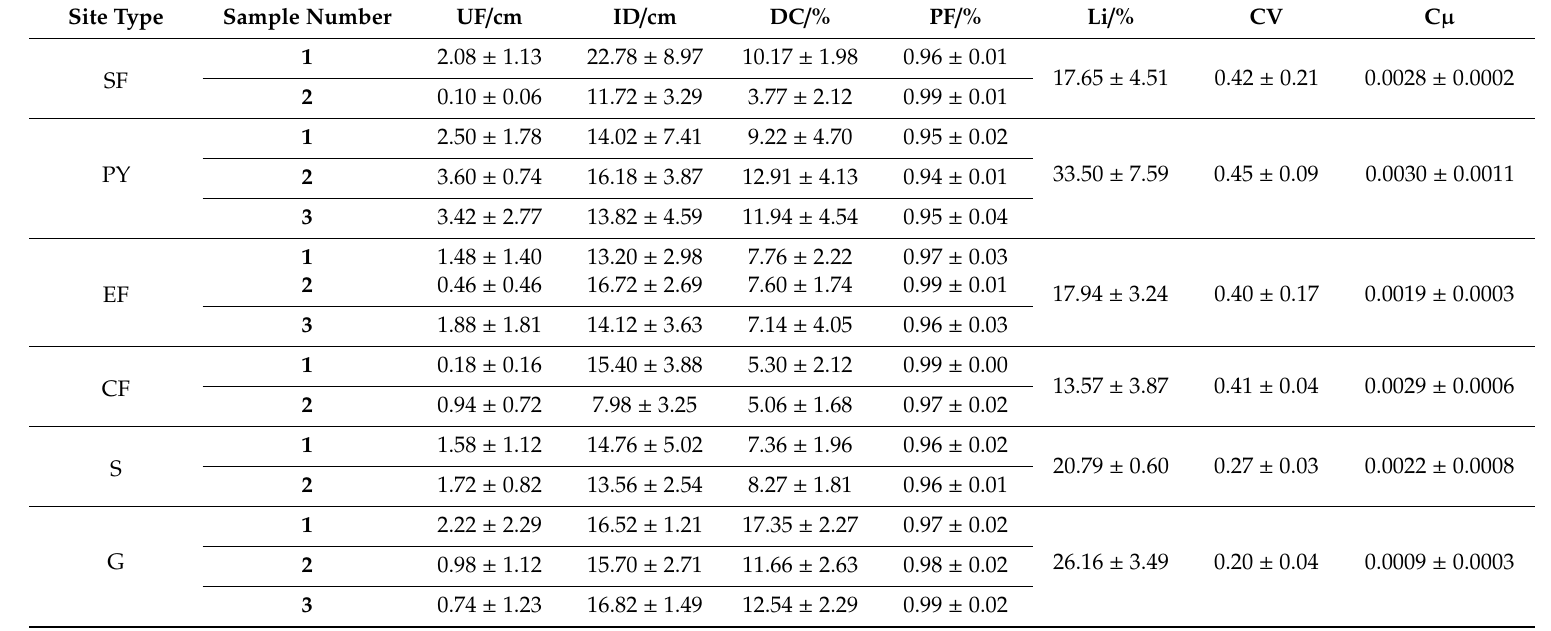
Table 3. Characteristic parameters of preferential flow variables. (G15). (average value ± standard